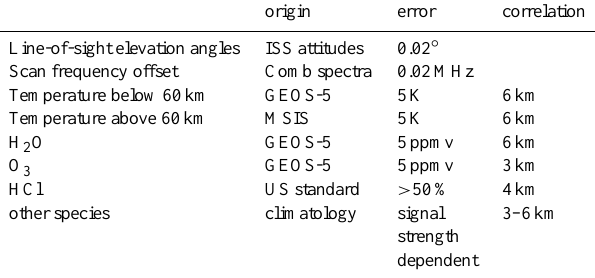
Table 4. Summary of the a priori information used in the a priori covariance matrix (Eq. 6). Errors and scale-length of autoregressive correlations are not representative of the real data, but are inversion regularisation parameters. Values for O 3 are given for the inversion of the 625.371GHz line and those for H 2 O are for the full spectral band